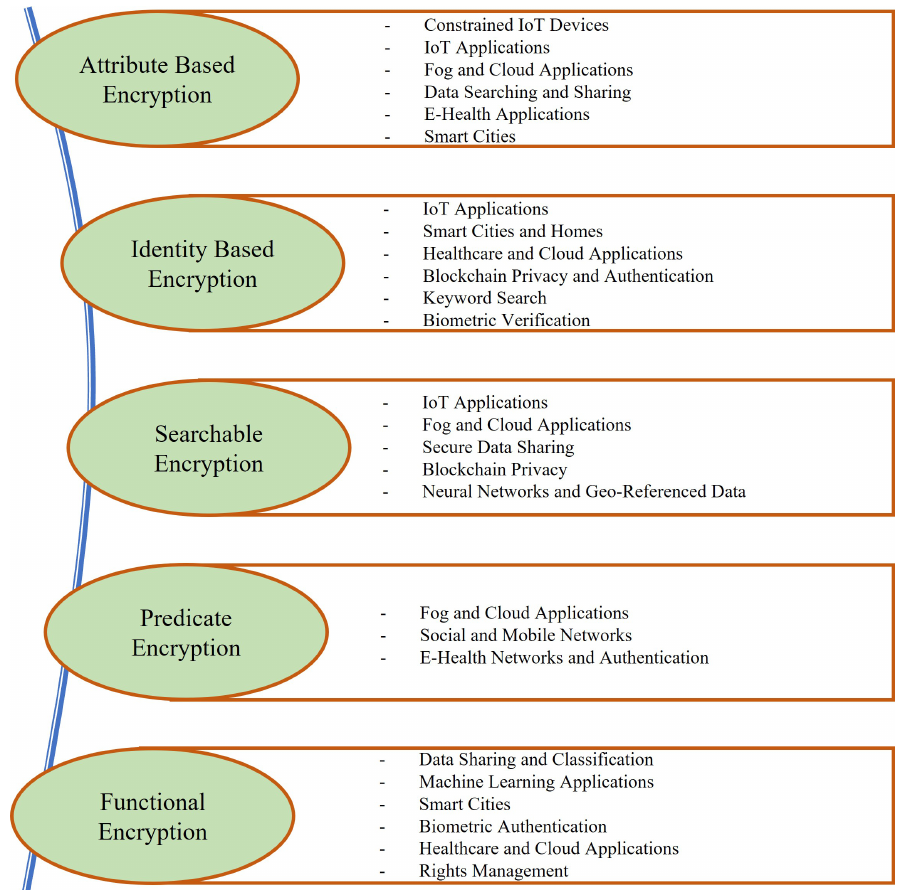
Figure 8. A list of applications covered in this work under considered cryptographic